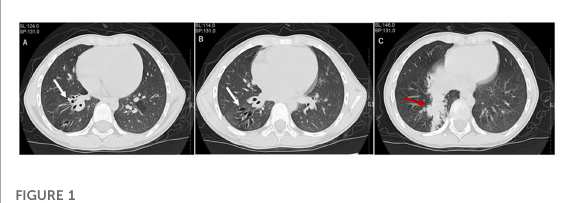
FIGURE 1 Features of a high-resolution computed tomography scan of the chest of this child. ( A,B ) It showed dilatation of the trachea in the right lower lobe bronchus. ( C ) It revealed airway mucus